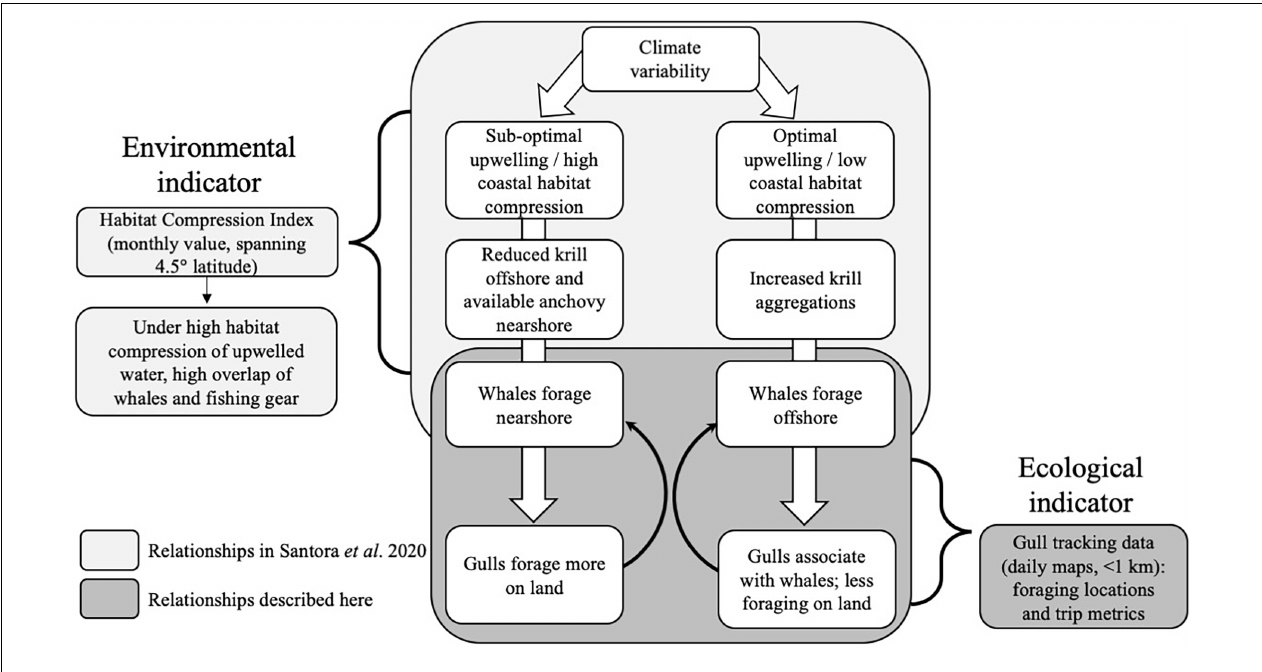
FIGURE 1 | Conceptual model showing how climate variability causes optimal or suboptimal upwelling habitat conditions that alters the distribution and/or abundance of prey and humpback whales, which leads to changes in western gull foraging behavior. The Habitat Compression Index (HCI) is an existing environmental indicator that was developed to predict the risk of interactions between crab fishing activities and humpback whales. In this study, we propose western gull foraging behavior as a new ecological indicator that provides higher-resolution information on ecosystem conditions compared to the